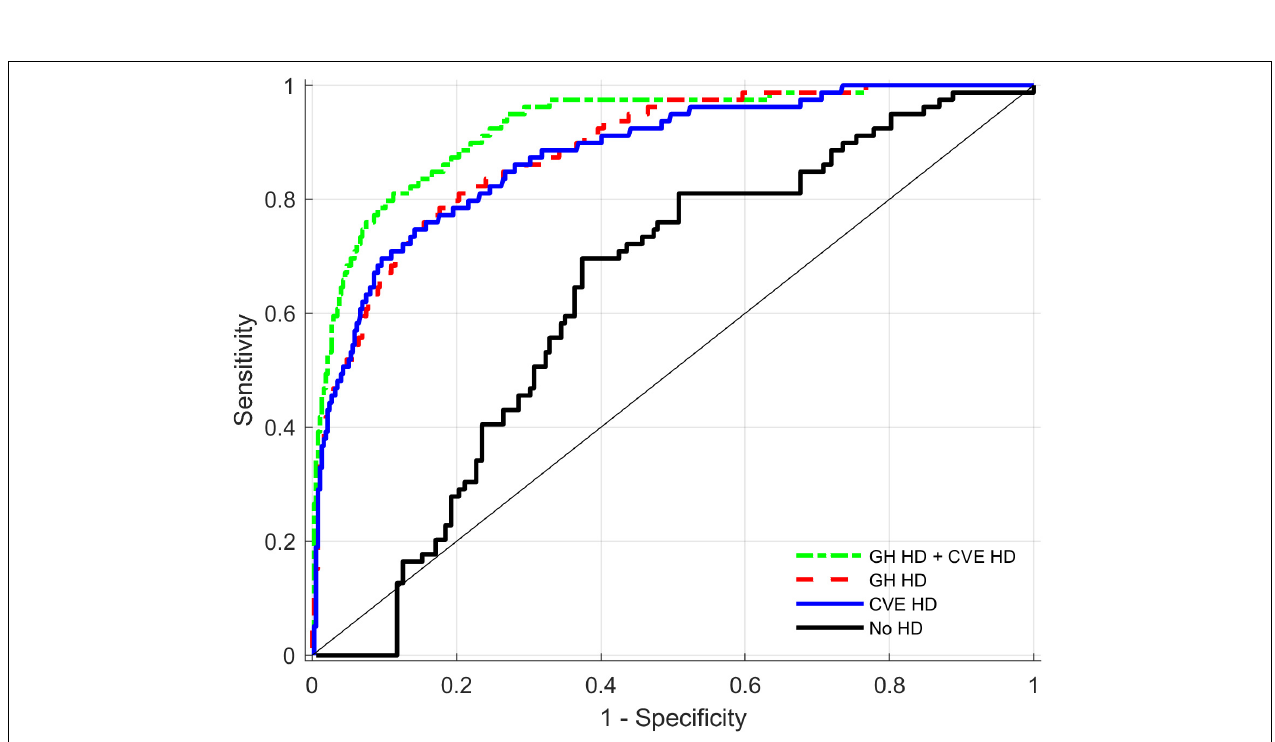
FIGURE 4 | Receiver operating characteristics (ROC) curves for Health distances (HD) of General health (GH), Cardiovascular endurance (CVE) and the combination of both HDs as predictors of Heart Failure. ROC curves present combined output from all imputed datasets (see section “Materials and Methods”).